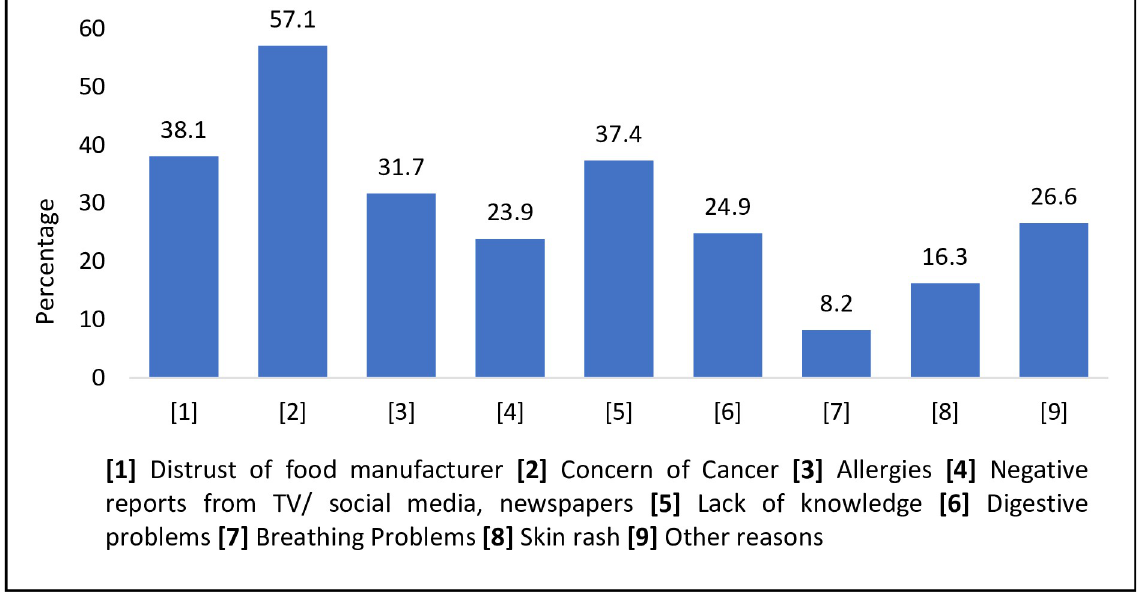
Fig 4. Concerns of the respondents about the safety of food additives (n = 1038).